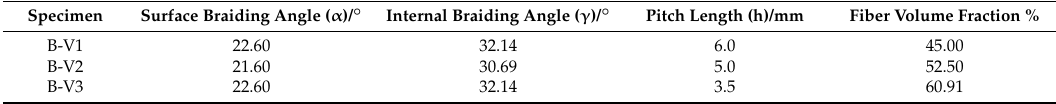
Figure 2. Geometry and sensor location for each specimen with ( A ) top and ( B ) side views. AE: acoustic emission. Table 1. Dimensions of each